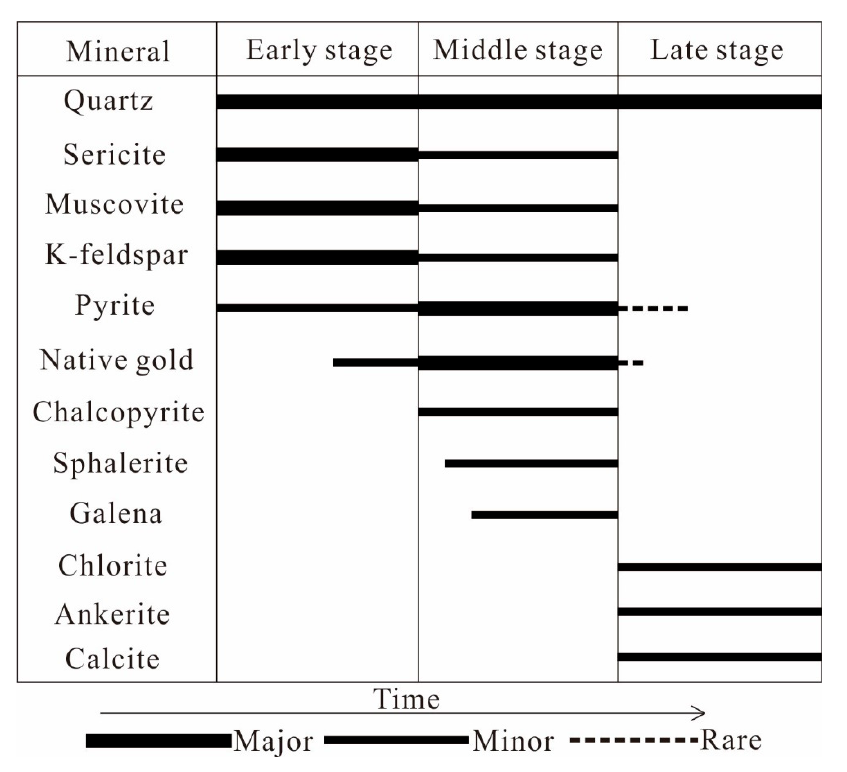
Figure 7. Paragenetic sequence for major minerals of the Liyuan gold deposit.